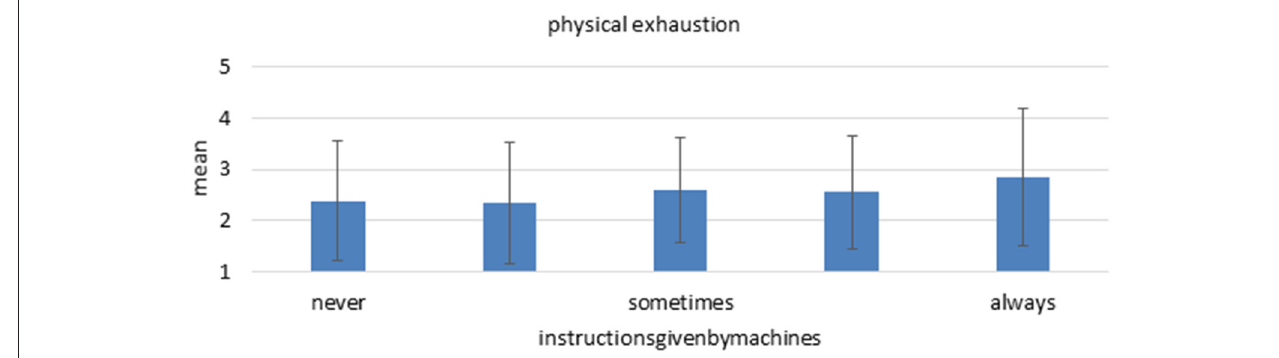
FIGURE 8 | Mean and standard deviation of the item “physical exhaustion” among the different “instructions by machines.” n = 2,356, linear regression coefficient beta = 0.101, p < 0.001.